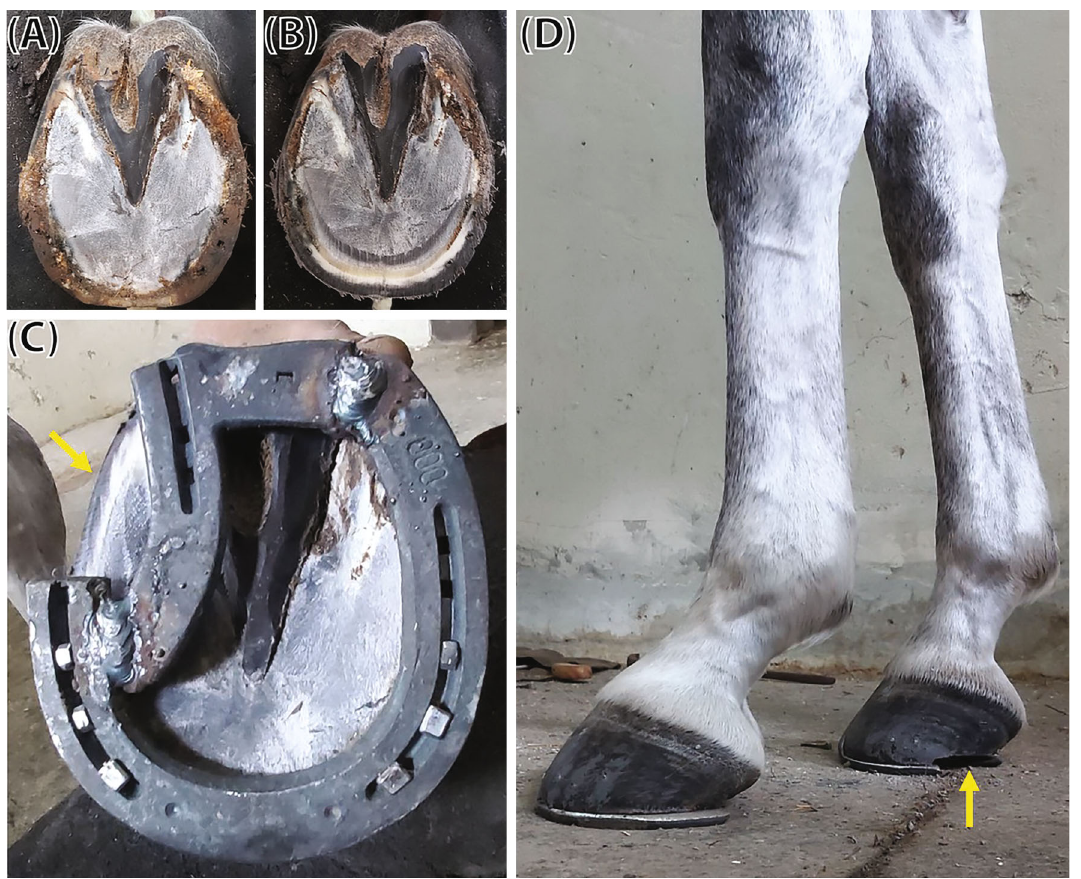
Figure 3: The application of the z-bar shoe on the a ff ected right front hoof. The hoof was trimmed and rasped before fi tting with the z-bar shoe (a, b). A non-weight-bearing portion was created on the medial side of the shoe base on the local anaesthesia area (yellow arrow) (c, d). Hoof conformation was adjusted bilaterally to increase the hoof angle and improve the hoof-pastern axis position